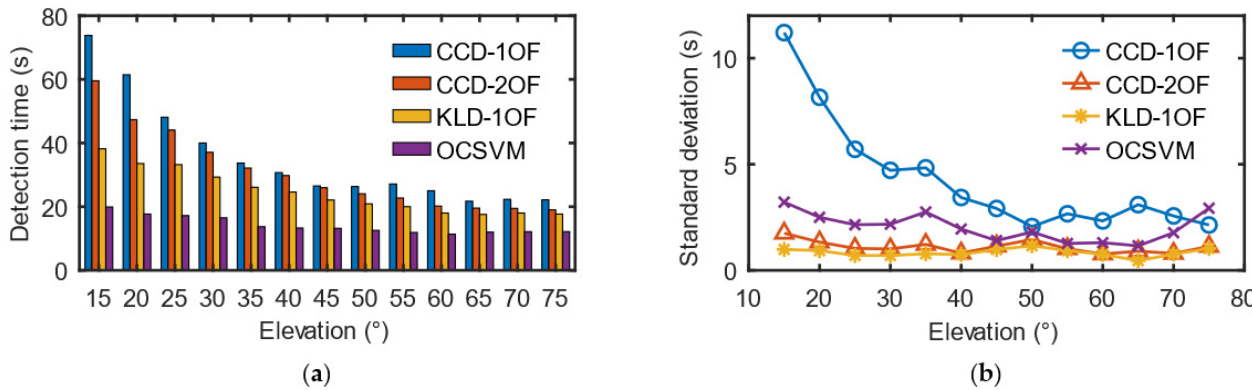
Figure 16. Comparison of the average ( a ) and the standard deviations ( b ) of the detection time of all BDS-2 satellites in relation to satellite elevations using the CCD-1OF, CCD-2OF, KLD-1OF and the proposed OCSVM-based monitors. The ionospheric gradient change with a rate of 0.02 m/s is added to all visible satellites.